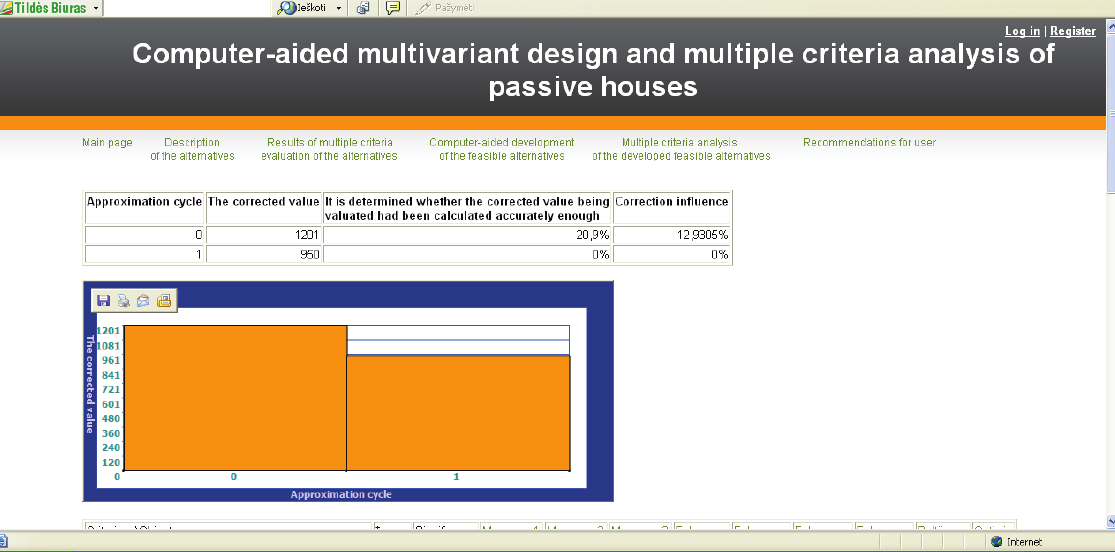
table 3. fragment of a market value analysis of the